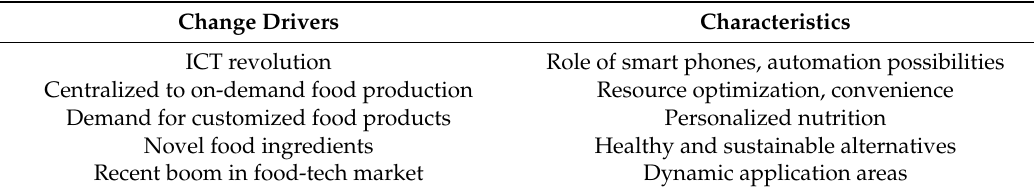
Table 2. Key change drivers for 3D food printing and its